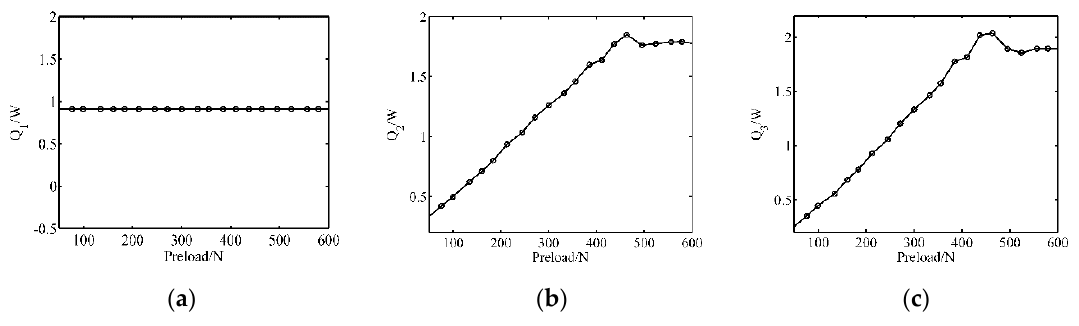
Figure 4. The respective power dissipation for the preload forces(Simulation): ( a ) Dielectric loss; ( b ) stator damping loss; ( c ) friction loss.